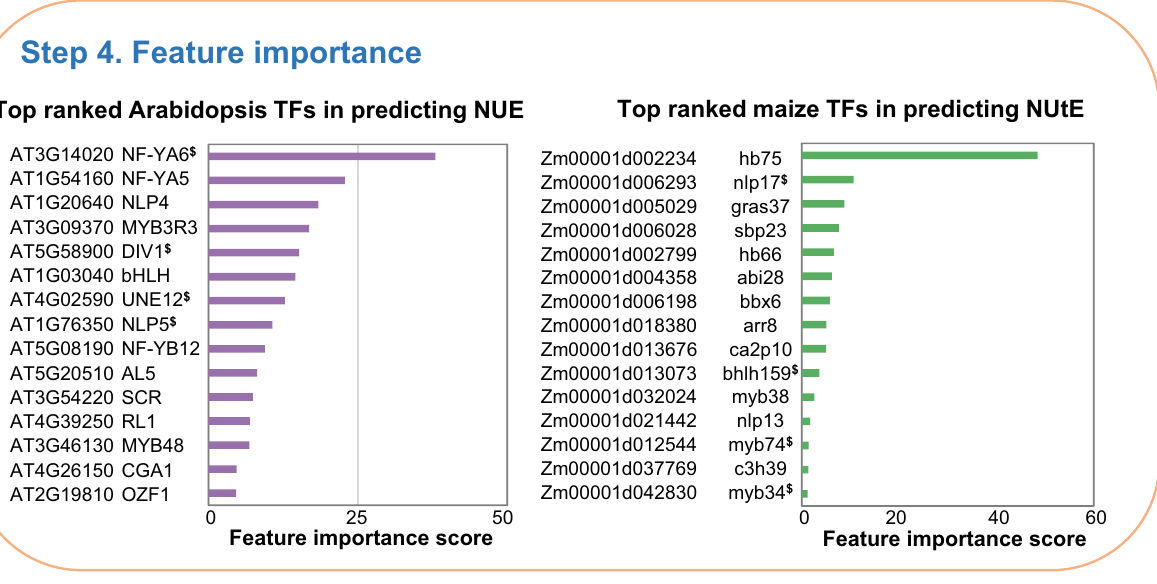
Crop-NUE: Maize XGBoost models predict NUE across